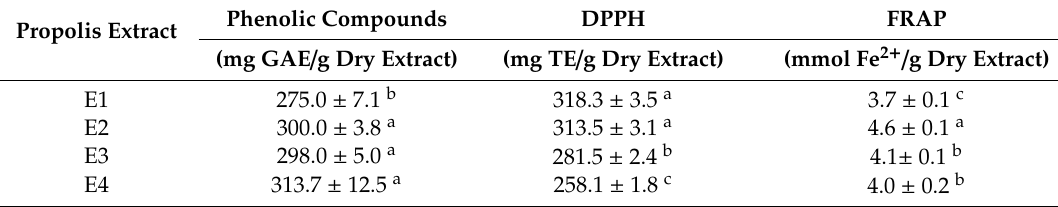
Table 1. Propolis extracts